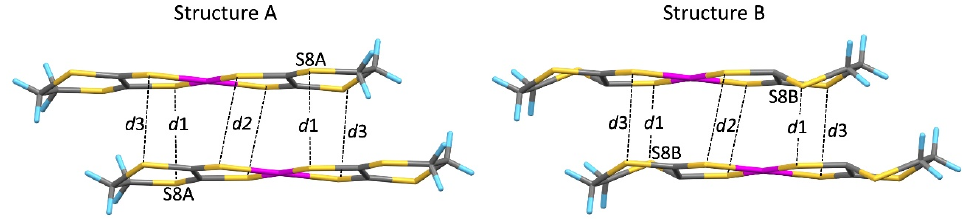
Figure 4. Two extreme crystal structures in which one of the possible conformations for molecule 2(4) is fully occupied (Structures A and B). Table 6. Intermolecular S···S distances (Å) between Molecules 2(4) in Layer 2 along the stacking direction. Ambient Pressure Ambient